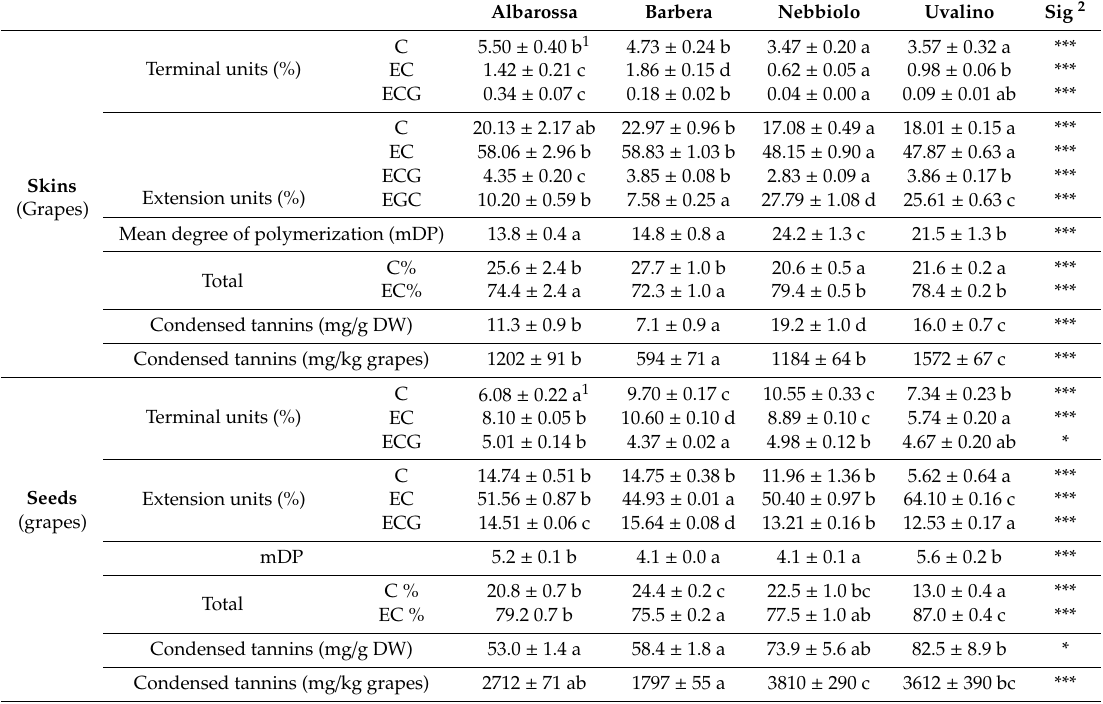
Table 4. Concentration, monomer percentage composition and mean degree of polymerization of condensed tannins in the grape skins and seeds, and ANOVA results. C = ( + )-catechin, EC = ( − )-epicatechin, ECG = ( − )-epicatechin-3- O -gallate, EGC = ( −